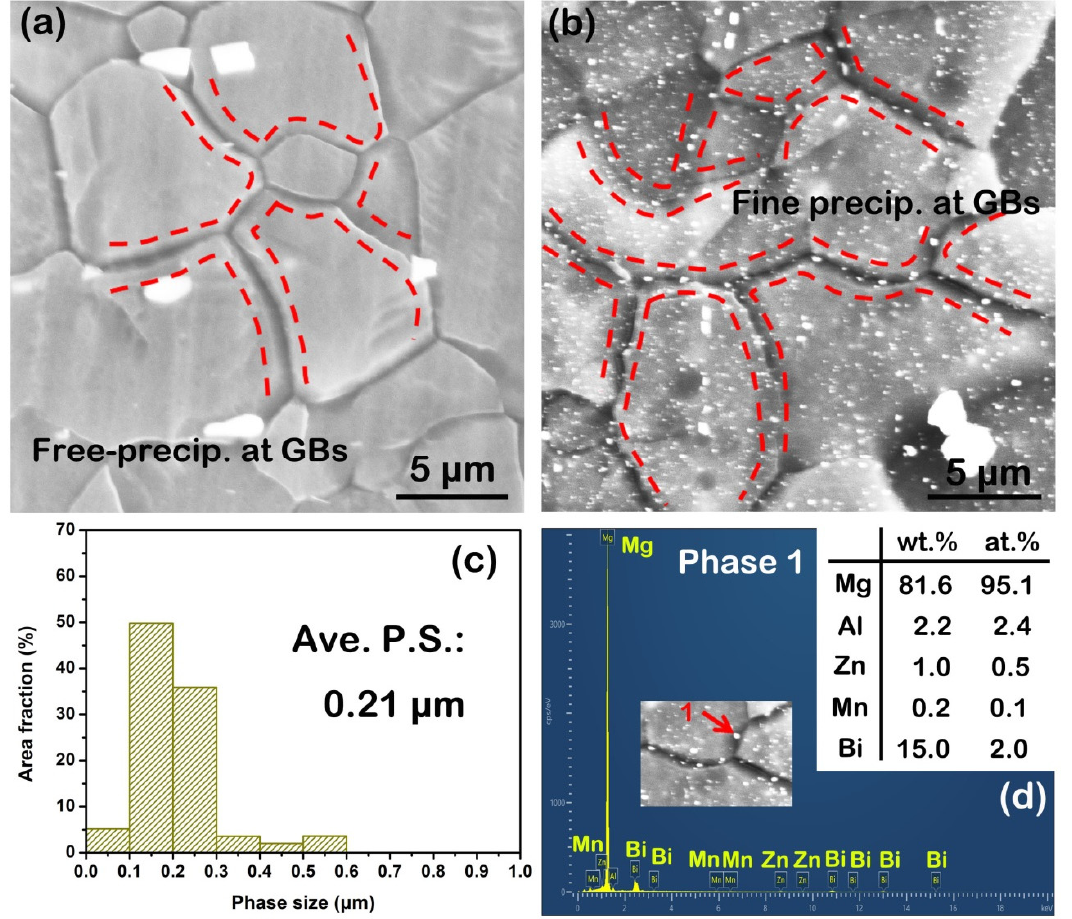
Figure 6. ( a , b ) High-magnification SEM images of as-extruded AZ31 and AZB313 alloys, respectively; ( c ) phase size distribution map of fine dynamic precipitates from ( b ); ( d ) SEM point scanning result of phases 1 marked by red arrow.